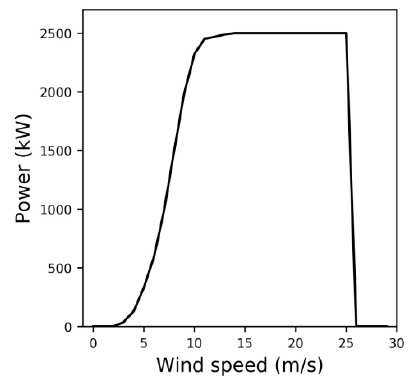
Figure 2. Power curve of the design performance of a G114-2.5MW wind turbine used in the wind power ramp detection. The turbine has a cut-in wind speed of 3 m/s, a rated wind speed of 13 m/s, and a cut-out wind speed of 25 m/s.